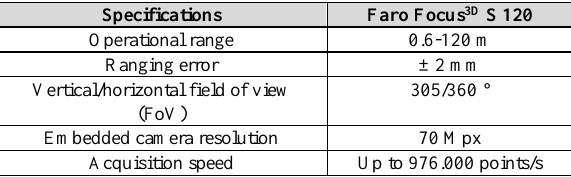
Table 3. Faro Focus 3D S 120 principal specifications.